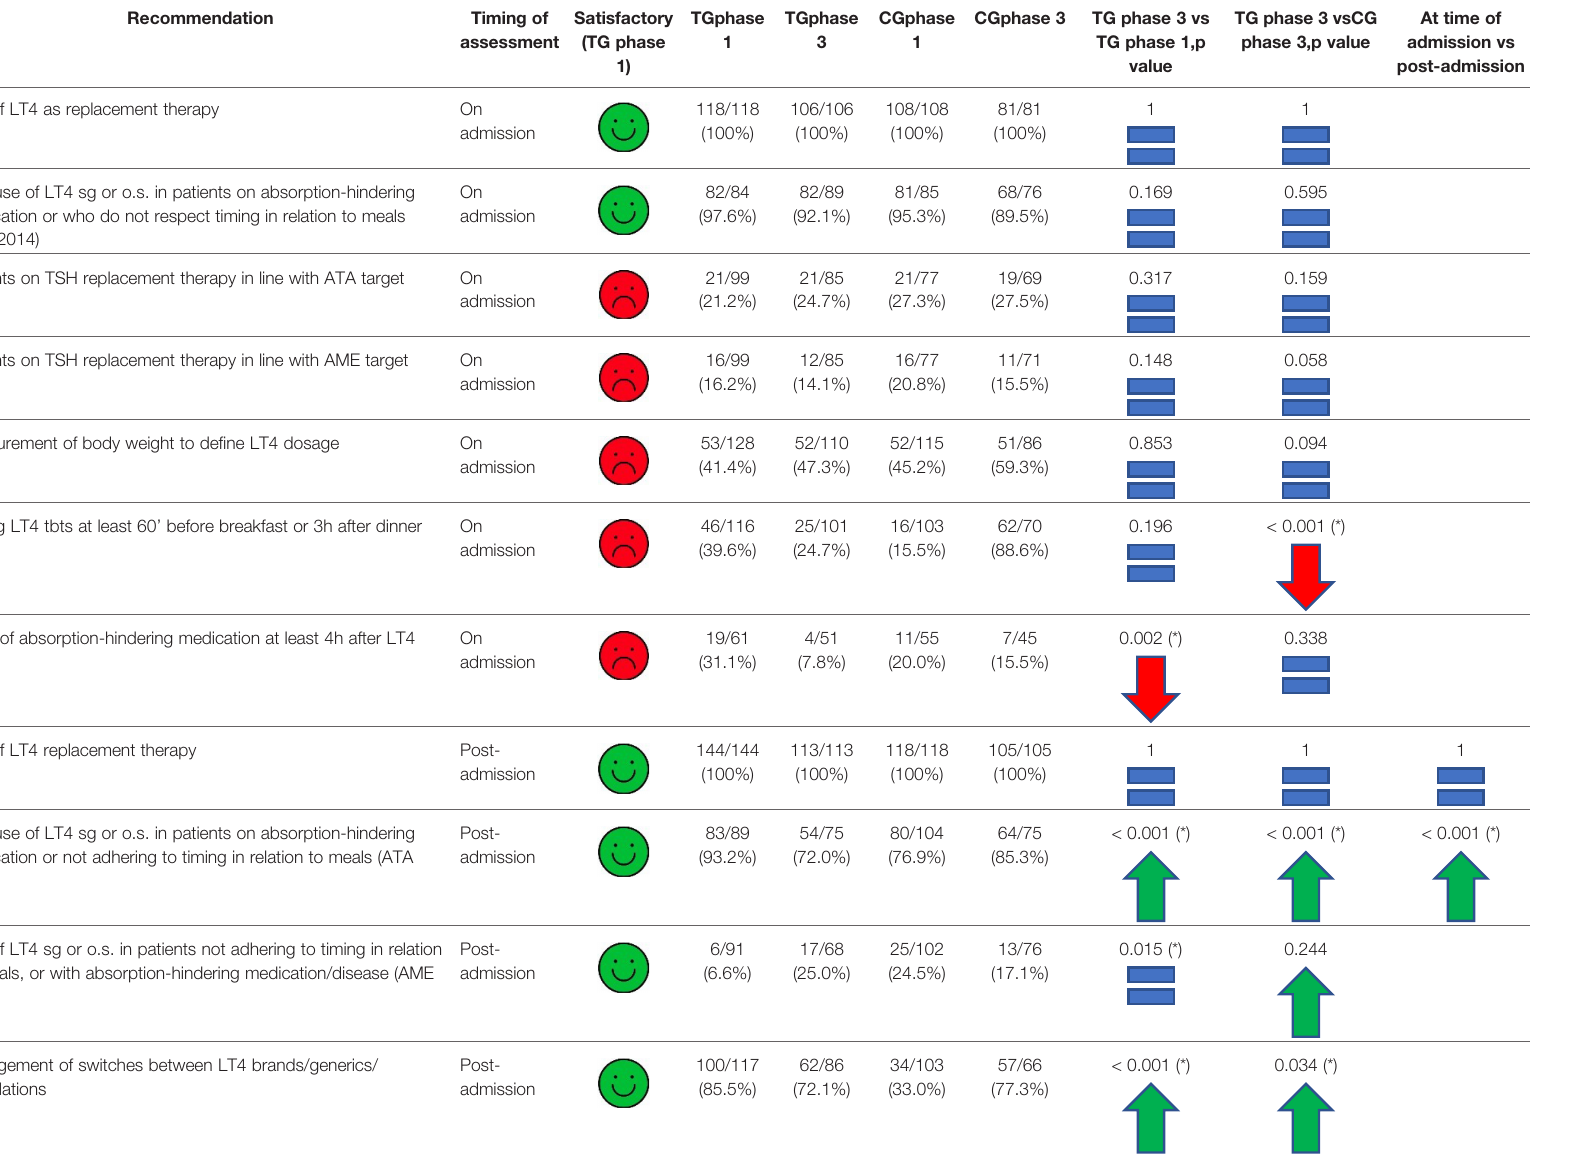
TABLE 4 | Indicators in phase 1 and phase 3, in the training group (TG) and control group